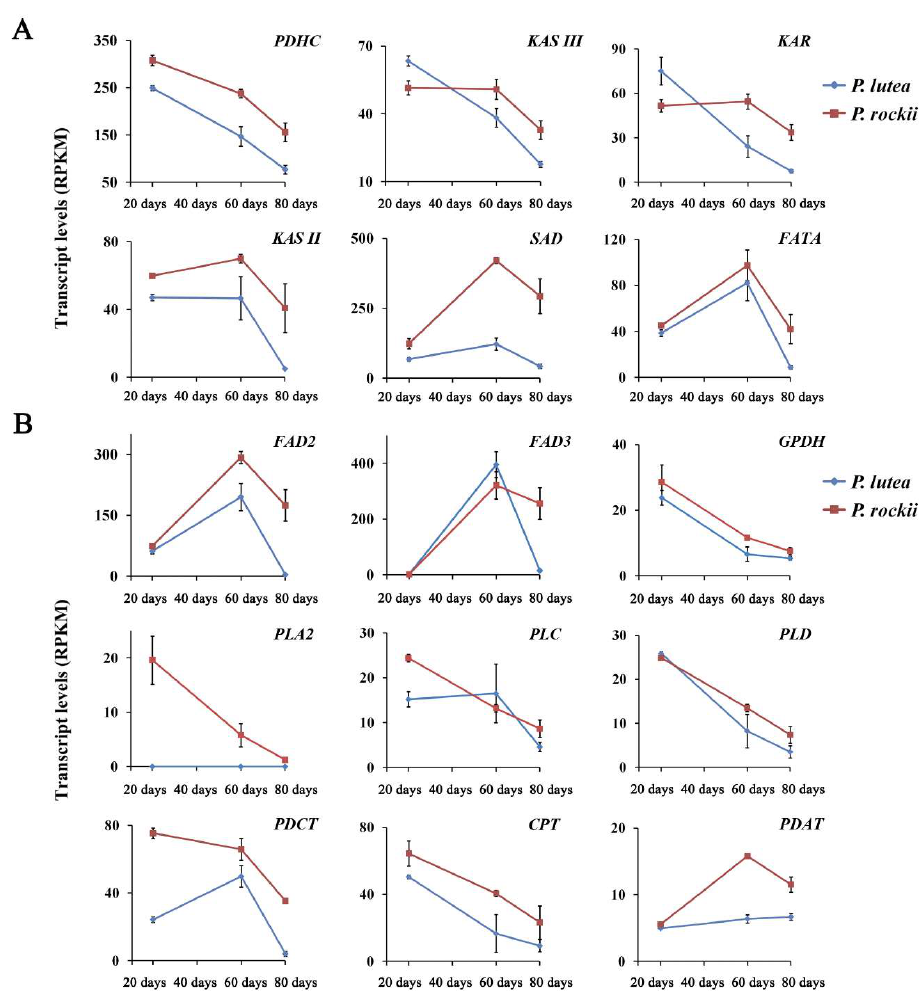
Figure 5. Comparison of expression pattern for select genes upregulated in P. rockii with P. lutea in ( A ) Figure 5 plastid and ( B ) endoplasmic